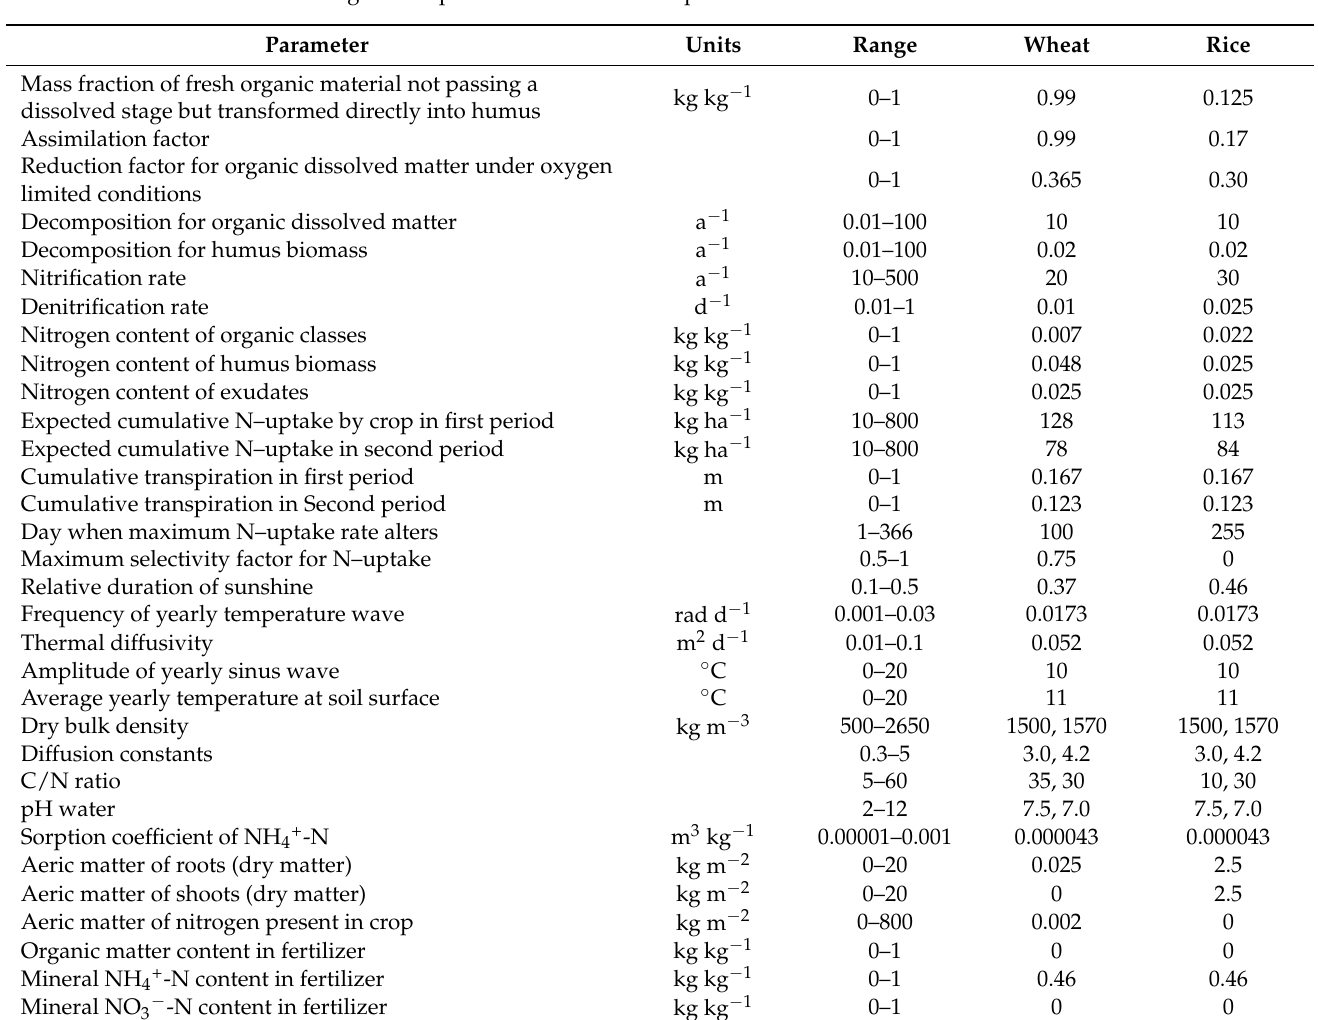
Table 2. Values of nitrogen transport and transformation parameters used for the SWAP- ANIMO